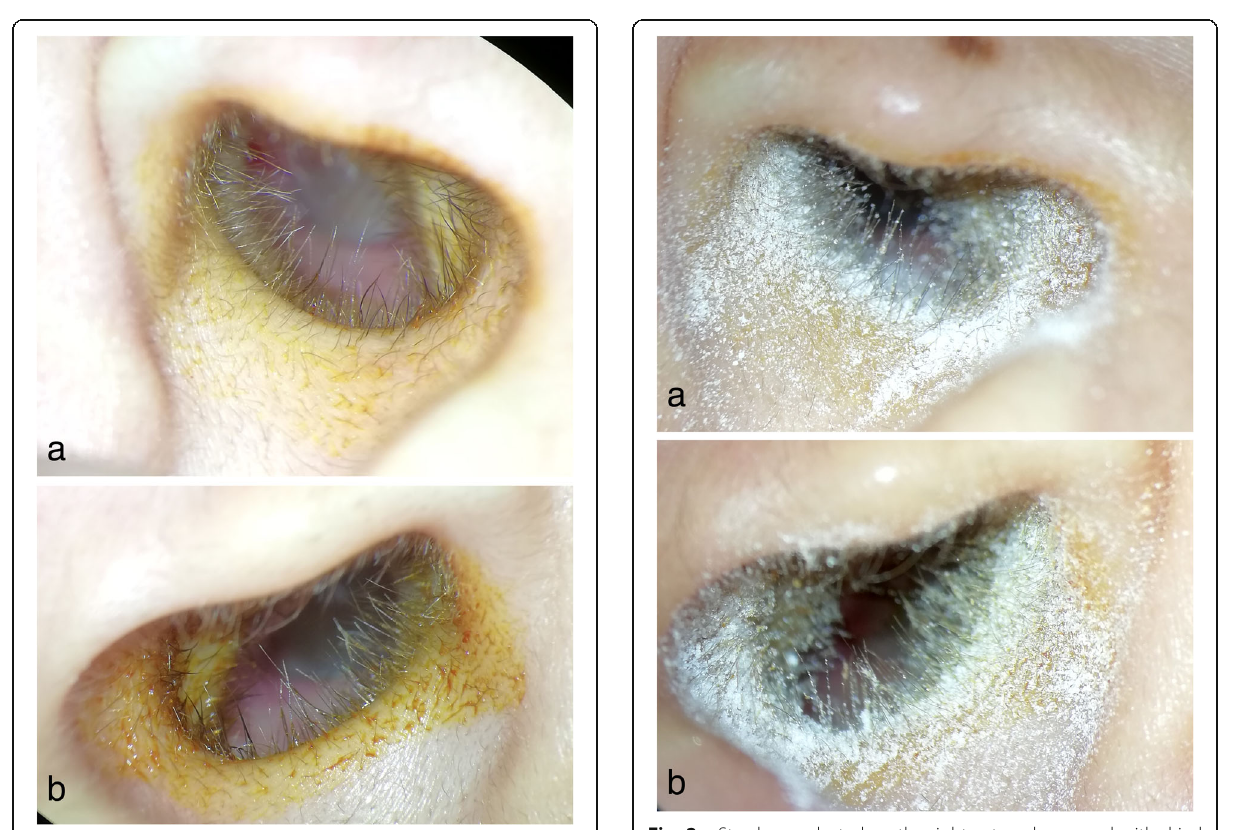
Fig. 2 a Starch was dusted on the right external ear canal with dried povidone. b starch was dusted on the left external ear canal with dried